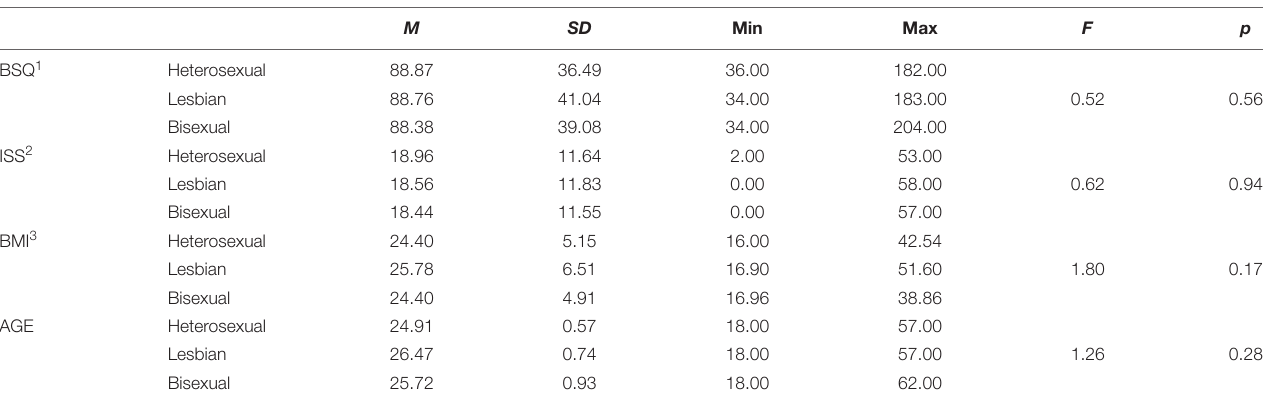
TABLE 2 | Descriptive statistics of BSQ, ISS, BMI scores and age, by sexual